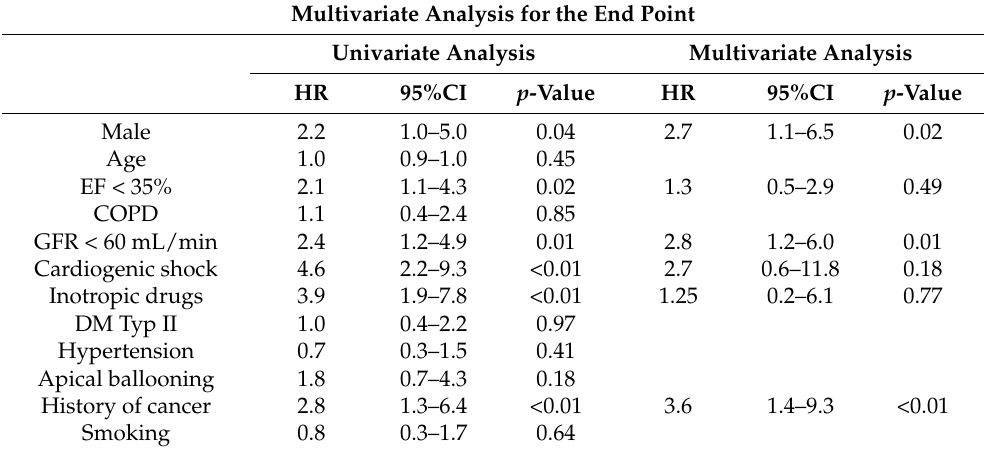
Table 4. Univariate and multivariate analysis for primary